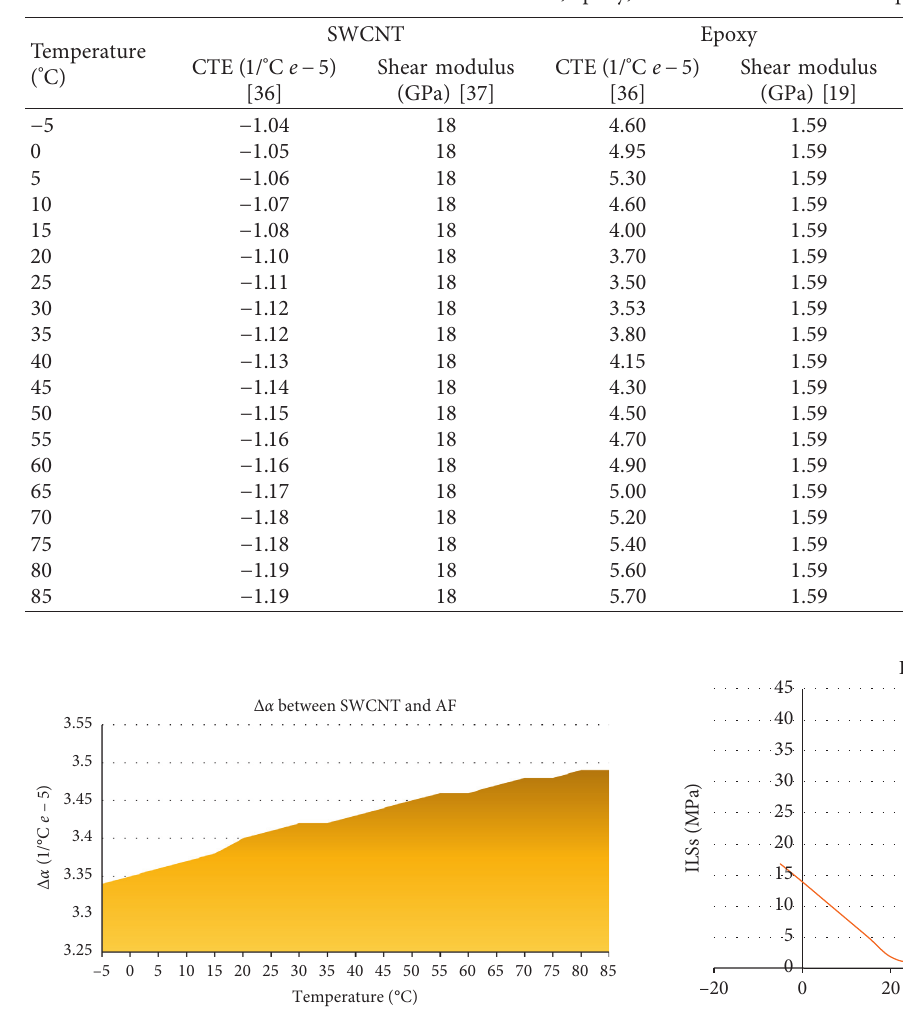
Figure 6: Mismatch between the CTEs of SWCNTand AF ( Δ α ) in temperature range of − 5 to 85 ° C within SWCNTAF.